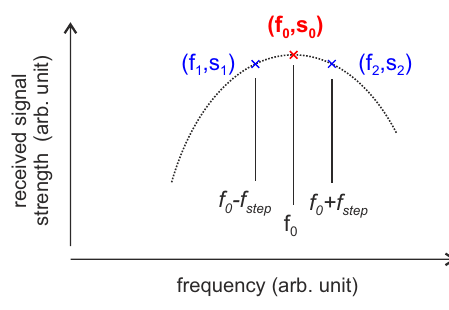
Figure 15. Pulsed FM/AM tracking loops with two-point interrogation